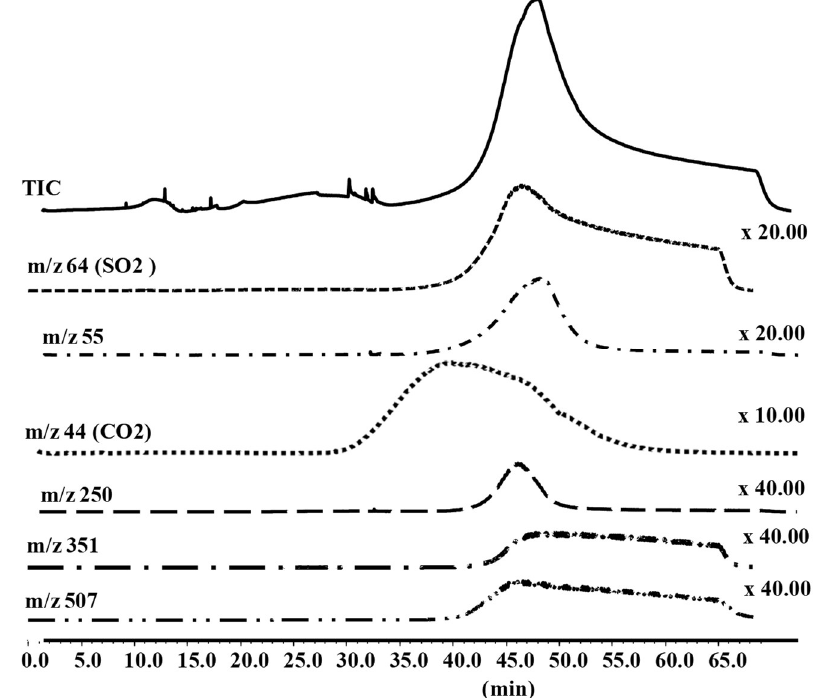
Figure 5. TIC trace and single ion curves (SIC) of the ions at m / z 44, 55, 64, 250, 351 and 507 evolved in the EI-DPMS of the P(ESDPA) homopolymer.